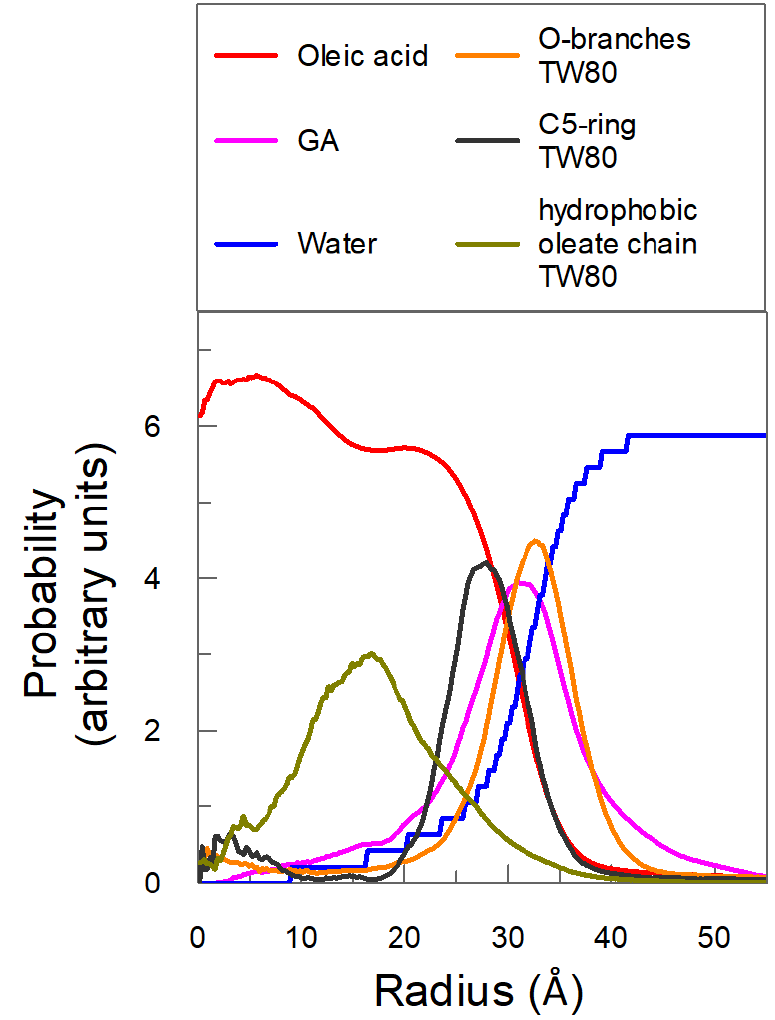
Figure 5. Density of probability of individual components of the nanoemulsion with respect to the center of mass of the oil core of the nanoemulsion droplet